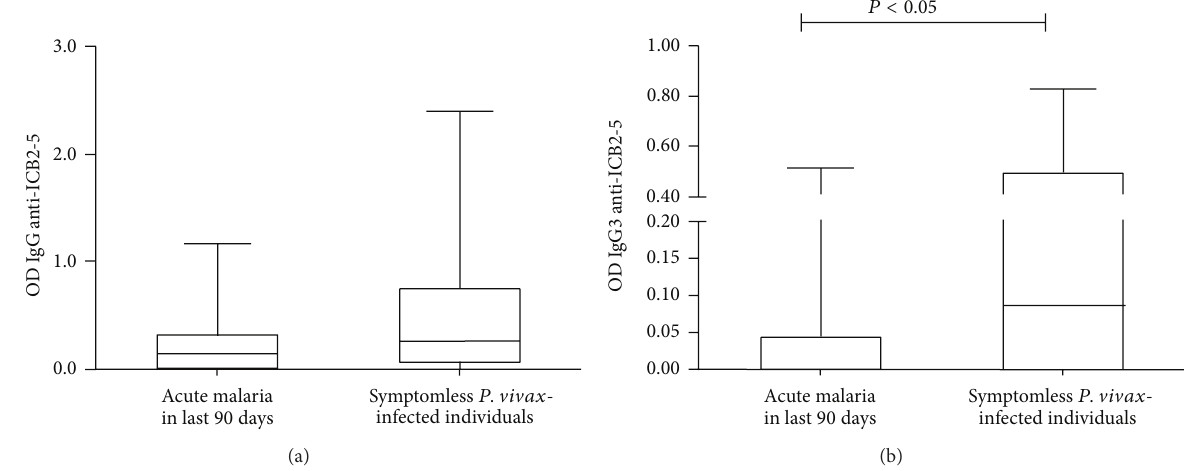
Figure 2: Comparison of total IgG and IgG3 levels against ICB2-5. Comparison of antibodies of individuals from study [42] separated according to subjects who have had acute malaria in last 90 days and symptomless P. vivax -infected individuals. Median of antibodies against ICB2-5 was compared by Kruskal Wallis. (a) Total IgG; (b) IgG3.